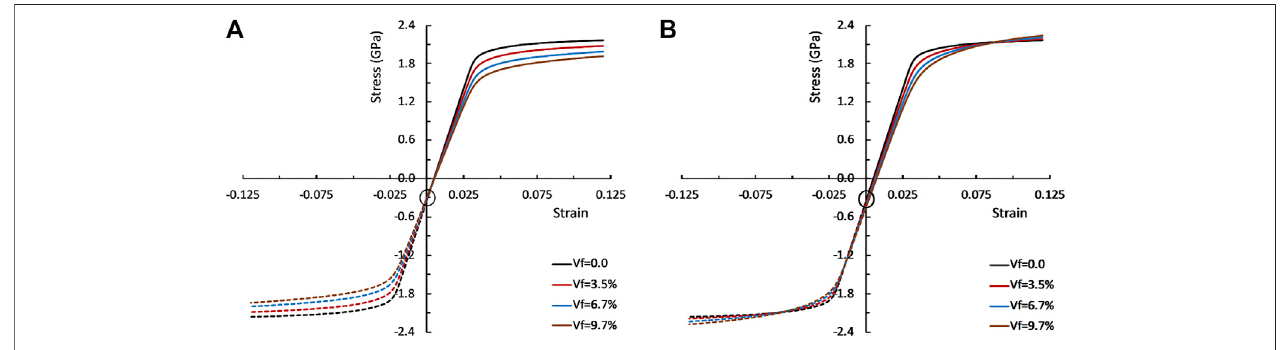
FIGURE 4 | Effect of gas bubble volume fraction and internal pressure on stress strain curves. Results shown are for gas bubbles with a pressure of (A) P gb (cid:2) 0 . 07GPa, (B) P gb (cid:2) 1 . 2GPa. Both tensile and compressive stresses are